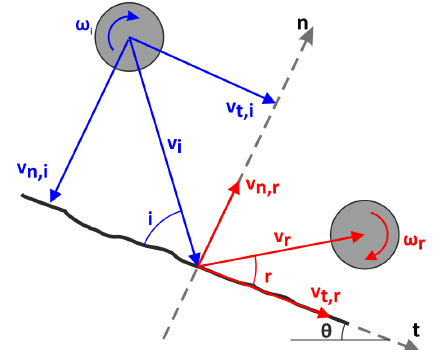
Figure 7. Coefficients of